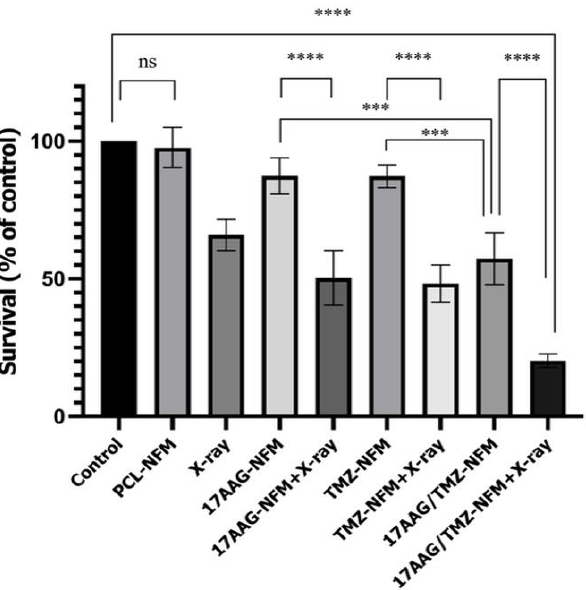
Figure 6. The survival rates of T98G cells treated with different NFMs for 24 h with or without X-ray irradiation. (Data are mean ± SD, **** p < 0.0001, *** p <0.001).